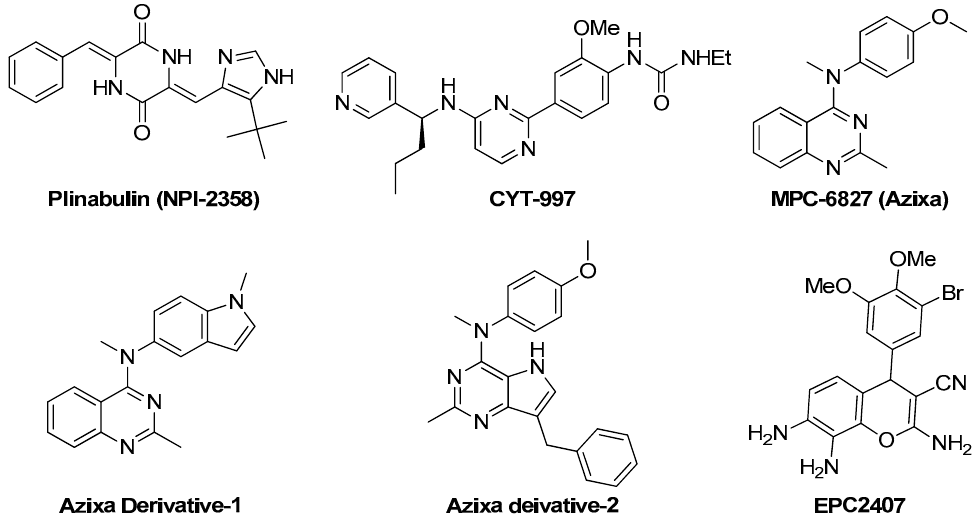
Figure 4. Examples of recently developed non CA-4 VDAs.